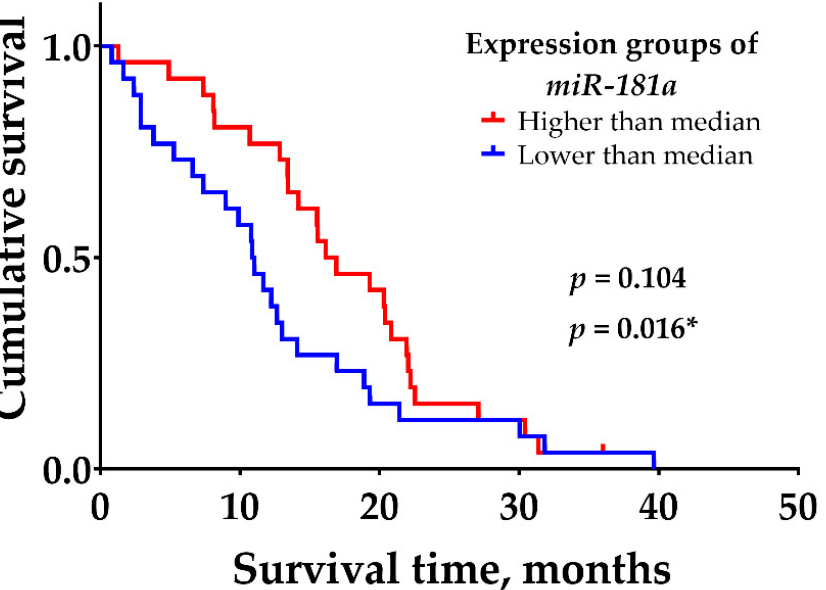
Figure 3. Survival analysis of patients with the diagnosis of IDH1 wild-type GBM in higher and lower miR-81a expression groups. p -values of log-rank test and * Gehan–Breslow–Wilcoxon test.